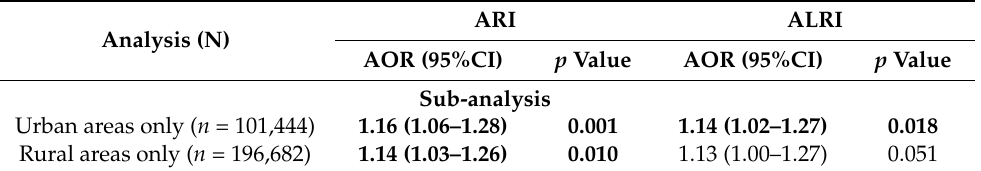
Table 3. Adjusted odds ratio (AOR) with 95% CI for the association of ARI and ALRI in children aged under five years with biomass cooking compared to cleaner cooking for rural and urban areas.